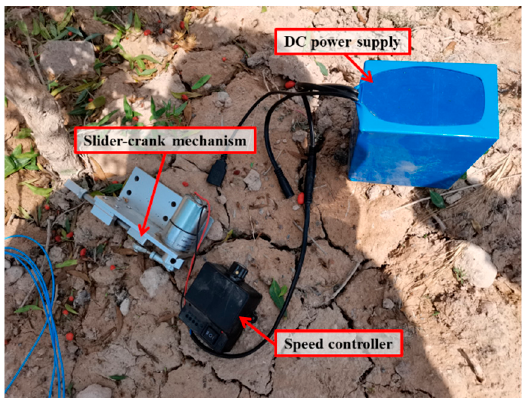
Figure 6. The device that could generate the frequency of 2 Hz.